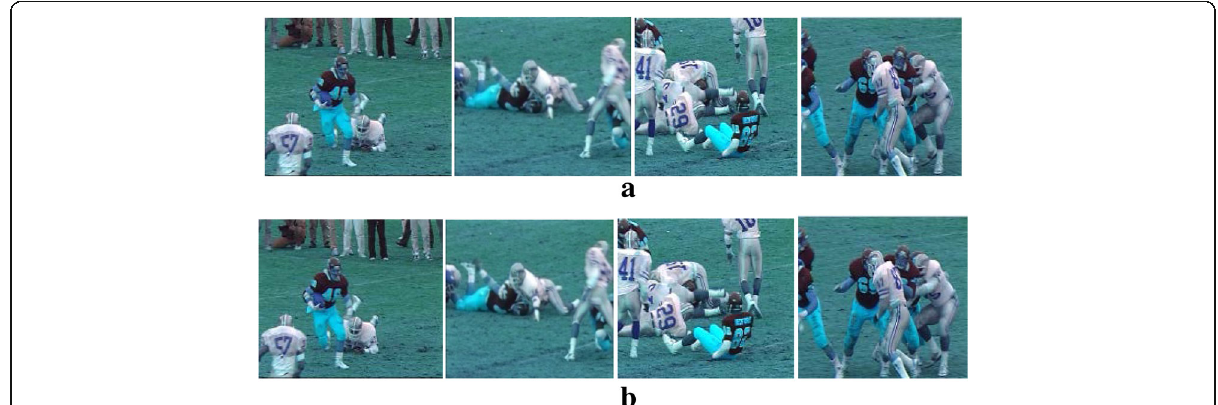
Fig. 11 Selected frames of stored video football.yuv (https://media.xiph.org/video/derf/). a original frames. b Decoded